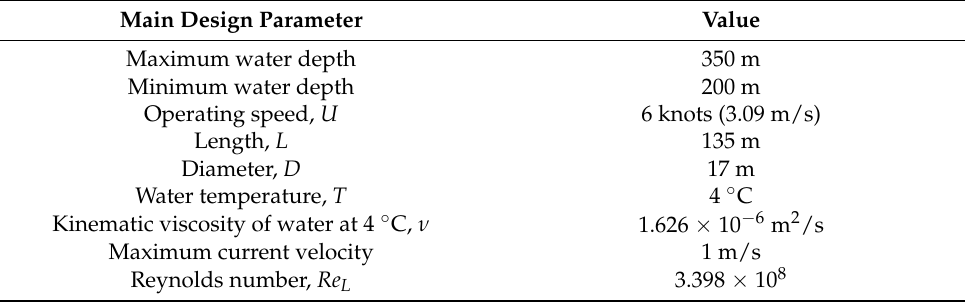
Table 2. Numerical settings